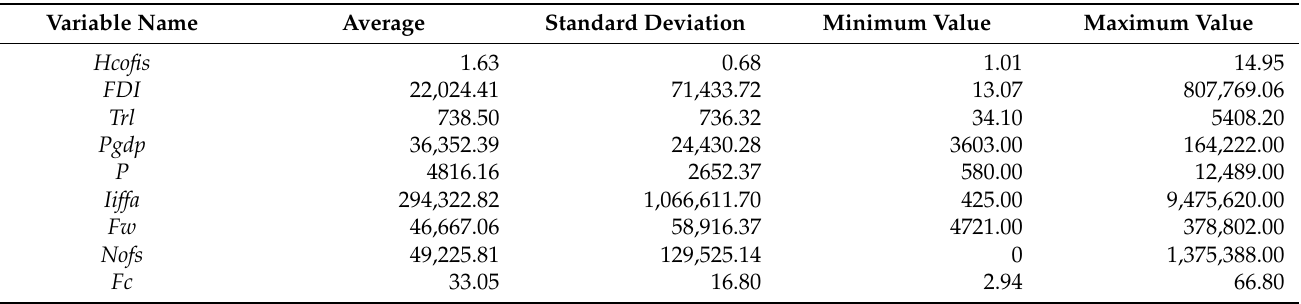
Table 4. Descriptive statistics